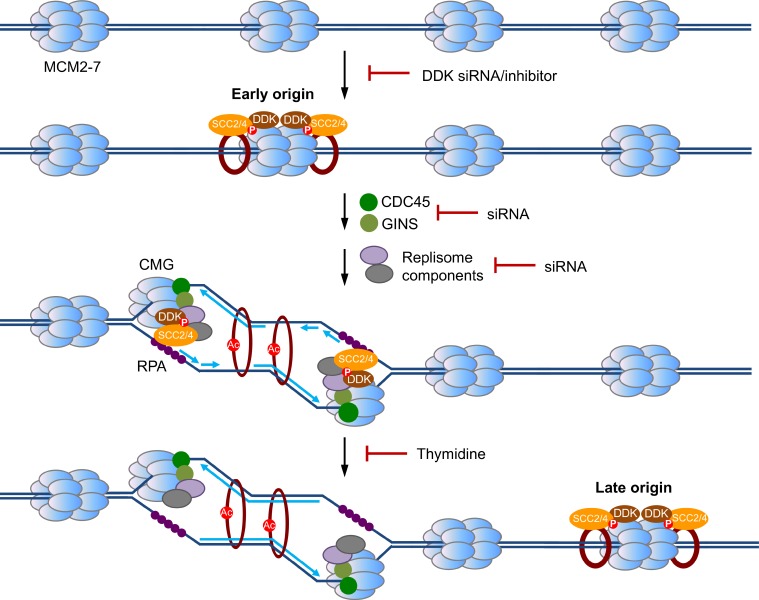
DDK-bound, potentiated MCM promotes cohesin loading and mobilization.Based on this model, only the potentiated MCM complexes bound to DDK (which is limiting) can recruit cohesin and SCC2/4 (NIPBL/MAU2 in humans). These potentiated complexes are destined to fire early during DNA replication, thus marking the early-replicating origins. In thymidine-arrested cells, a large fraction of these early-replicating origins has fired. Continued binding of cohesin and SCC2/4 at these origins requires replisome components in these early S phase cells. During S phase progression, DDK is mobilized and binds to other MCM complexes. These potentiated MCM complexes at late-replicating origins then recruit cohesin and SCC2/4 and repeat the process of cohesin loading and mobilization.